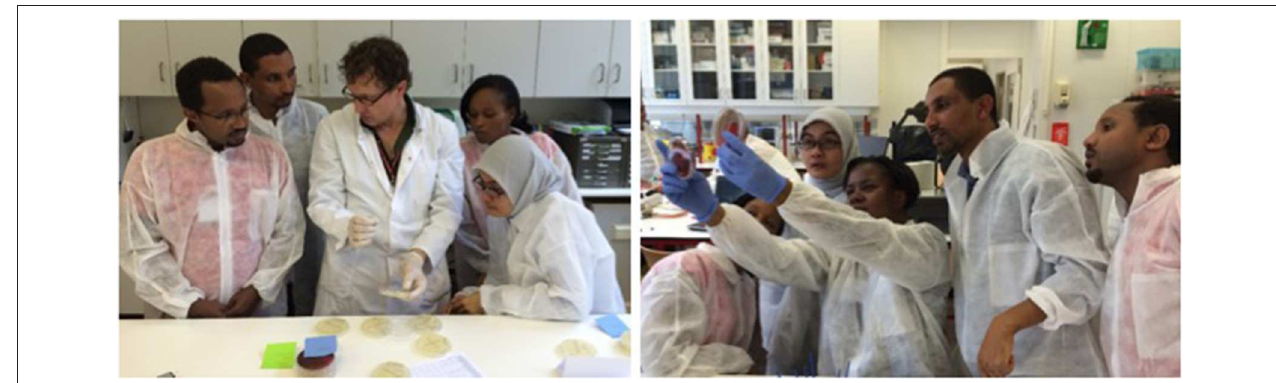
FIGURE 3 | During so-called “ Plate Rounds ,” clinicians and laboratory staff meet in the laboratory and discuss selected cases of infections in a didactic setting. Culture plates including AST results are shown and discussed (e.g., de-escalation of antibiotic treatment (84). Moreover, Plate Rounds can be connected to remote expert advice by telemedicine (180). Originally conceived as a training tool applied in academic medical centers, Plate Rounds provide excellent opportunities for diagnostic and antibiotic stewardship and create liaisons between clinicians and laboratory staff, trainees and in case pharmacists and IPC team (84). The pictures above are “ Plate Rounds ” set-up during the short course “ Hospital-based Interventions to Contain Antibiotic Resistance in Low-resource Settings ” at the Institute of Tropical Medicine. Participants of the microbiology track demonstrate case-based laboratory cultures to their colleagues from the antibiotic stewardship and infection prevention and control tracks (181). Written informed consent was obtained from the individuals for the publication of this